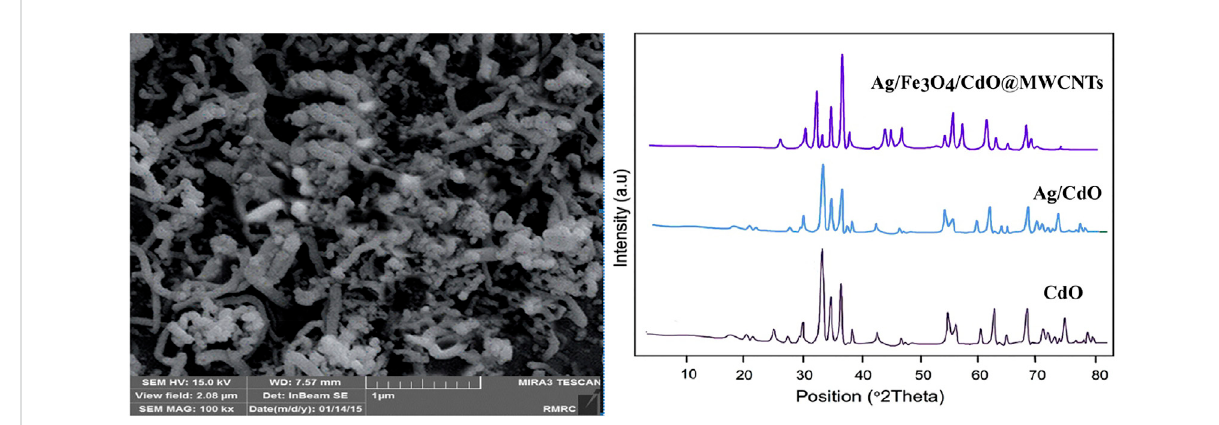
FIGURE 1 Left: SEM image of Ag/Fe 3 O 4 /CdO@MWCNT MNCs. Right: the XRD analysis of Ag/Fe 3 O 4 /CdO@MWCNT MNCs.